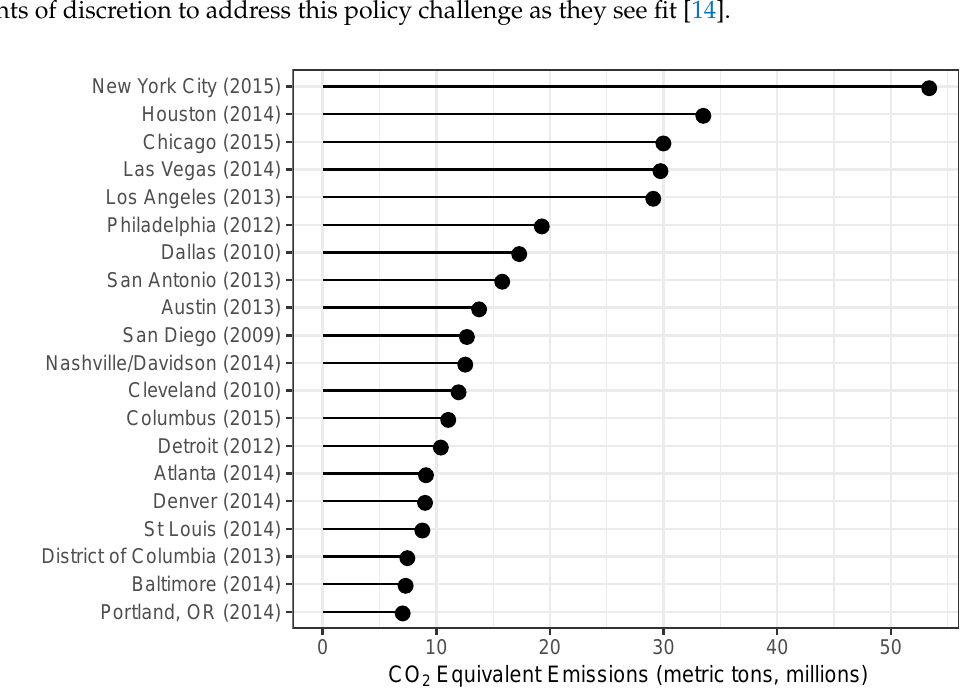
Figure 1. Top 20 U.S. city emitters of carbon dioxide equivalent. This figure displays the carbon dioxide equivalent emissions (millions of metric tons) for the top 20 emitters amongst U.S. cities. Estimates are retrieved from Nangini et al.